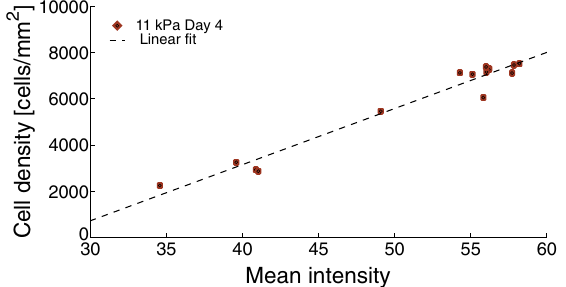
FIG. 11. Relation between cell number density and mean intensity of the confocal images. During image post-treatment, cell clusters are divided into equidistant rings, where the central region is a circle with a radius of 350 μ m. The image segments taken from the different regions in the cell clusters are analyzed, and a linear mapping between average cell density and image intensity is found for each cluster. The figure illustrates the linear mapping extracted from the experiments realized on day 4 for tissues grown on 11 kPa